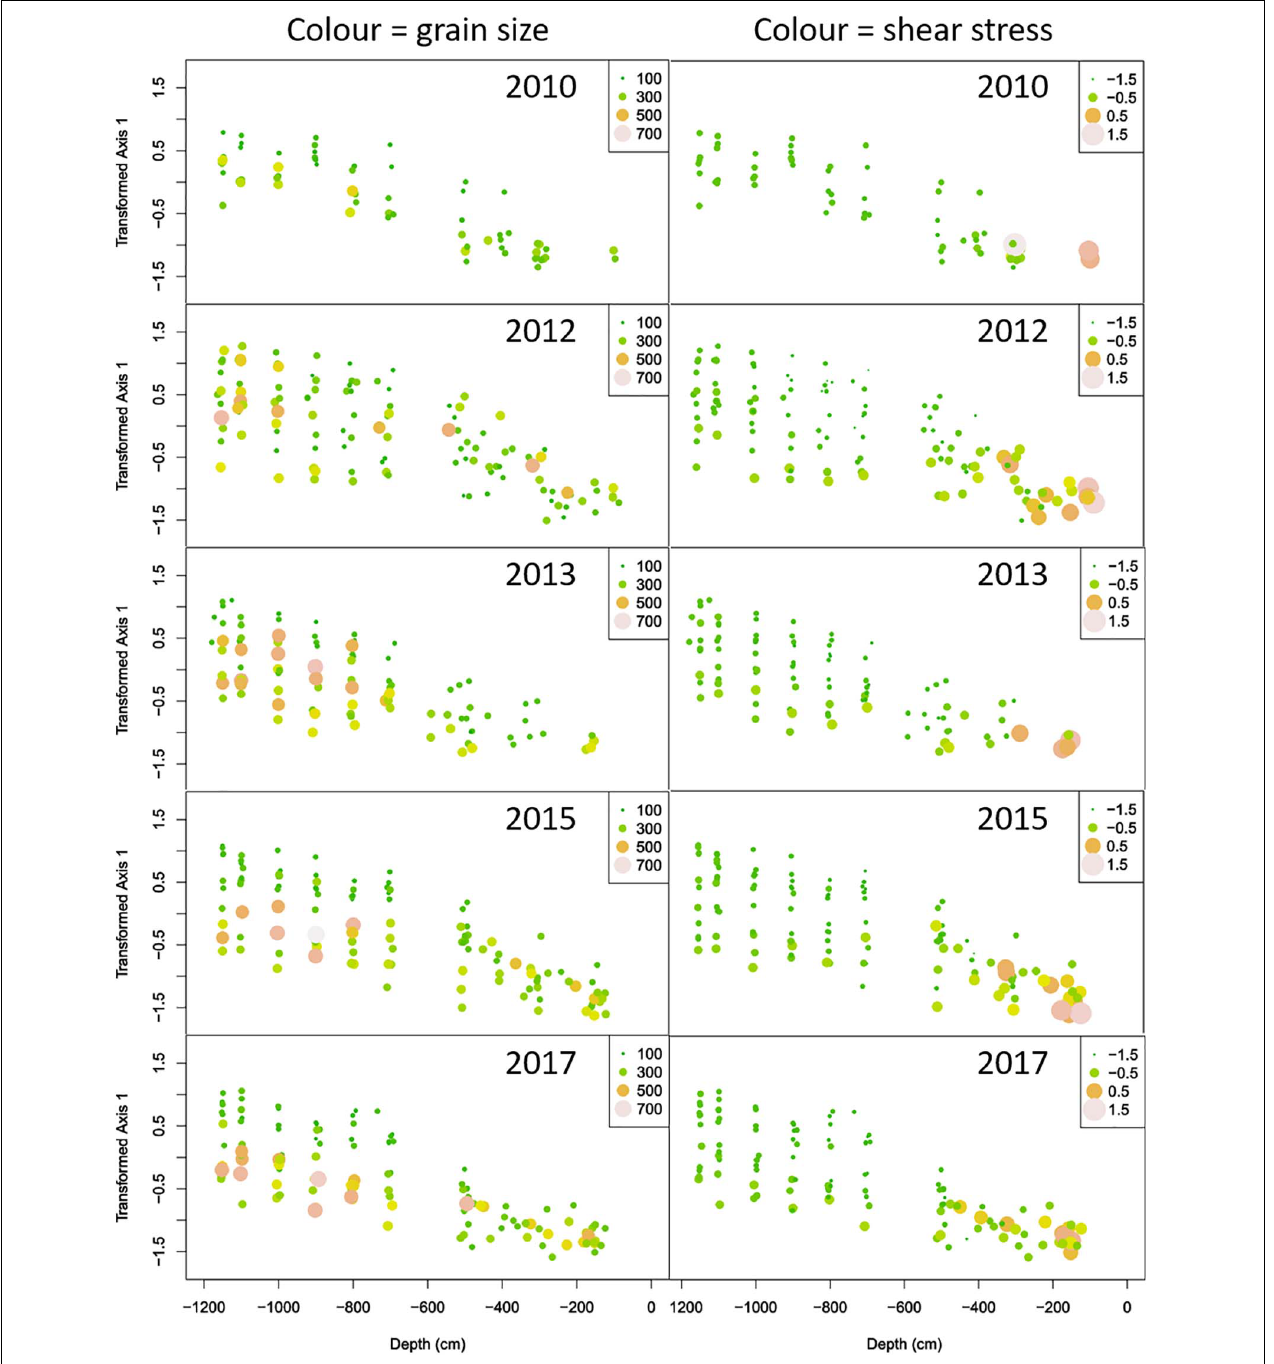
FIGURE 9 | Plots of the (transformed) axis 1 scores versus depth for the years before (2010) and after the construction of the Sand Motor. The plots in the left and right columns show the same points. Color and size in the leftmost columns show the median grain size, while in the rightmost columns they show log-transformed bottom shear